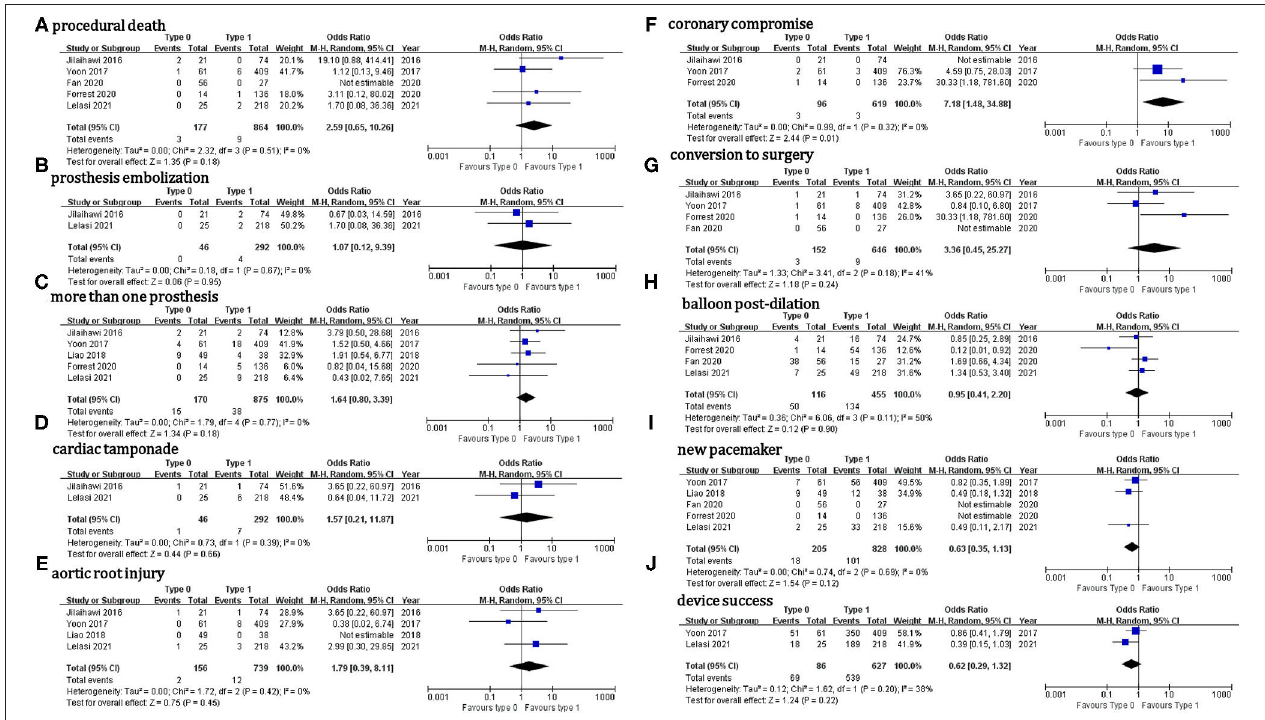
FIGURE 2 | In-hospital outcomes.